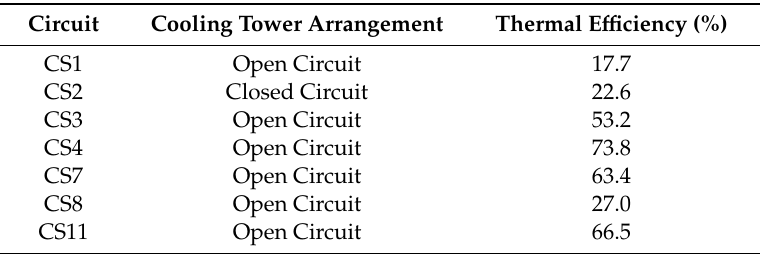
Table 12. Cooling tower thermal e ffi ciency for cooling and gas washing